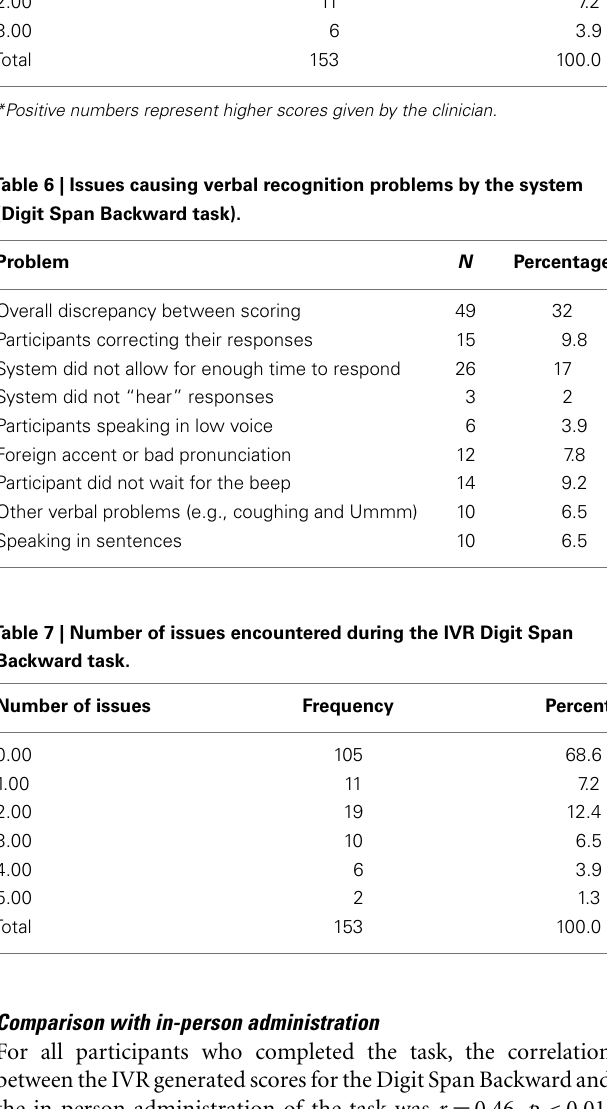
*Positive numbers represent higher scores given by the clinician.